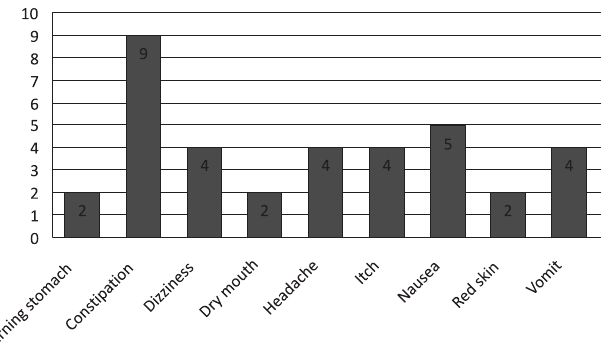
FIGURE 2 - Drugs suspected of causing ADR. Campina Grande, 2010. TABLE II - Anatomical therapeutic chemical classification